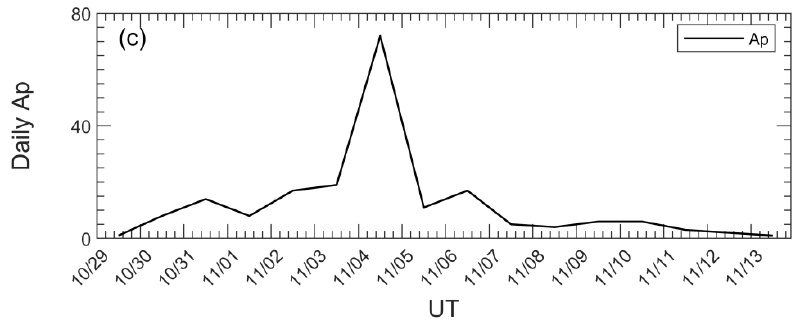
Figure 2. Variation of atmospheric density and spatial environmental indexes with time: ( a ) simulations and observations; ( b ) F10.7 index; ( c ) Ap index.